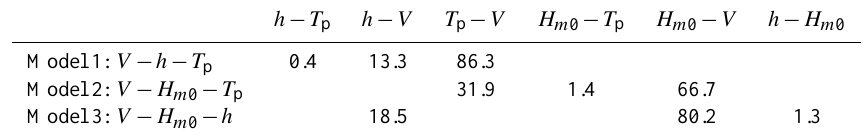
Fig. 6. Comparison of measured and predicted values of depth-integrated suspended sediment transport. Predictions have been made using an ANN with 3 inputs and 3 nodes in 1 hidden layer. Inputs are: (A) h , H m 0 , V ; (B) T p , H m 0 , V ; (C) T p , h , V ; (D) h , H m 0 , T p . The solid line indicates equality and the dashed lines indicate a factor 5 difference between the predicted and observed values. Table 2. Percentage of the contribution of combinations of variables for the 3 best-performing models presented in Fig.